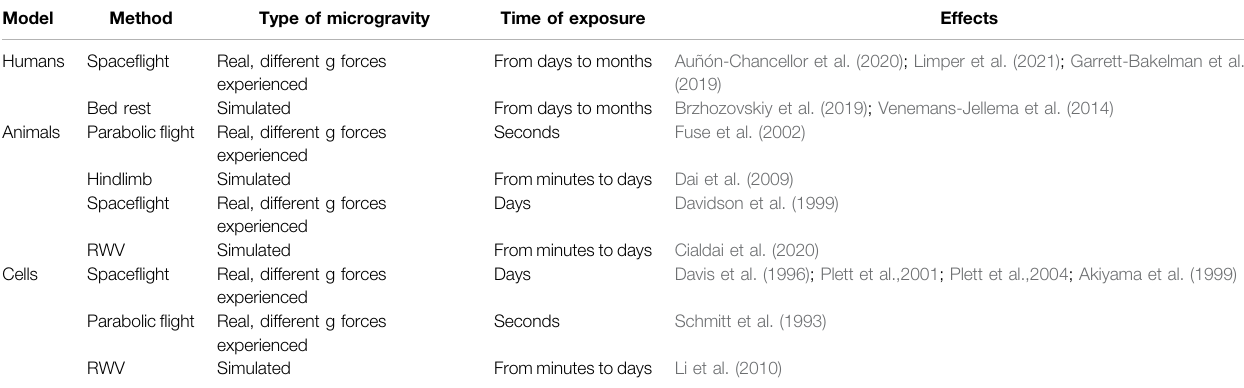
TABLE 1 | Summary of the studies on platelets in microgravity using different experimental